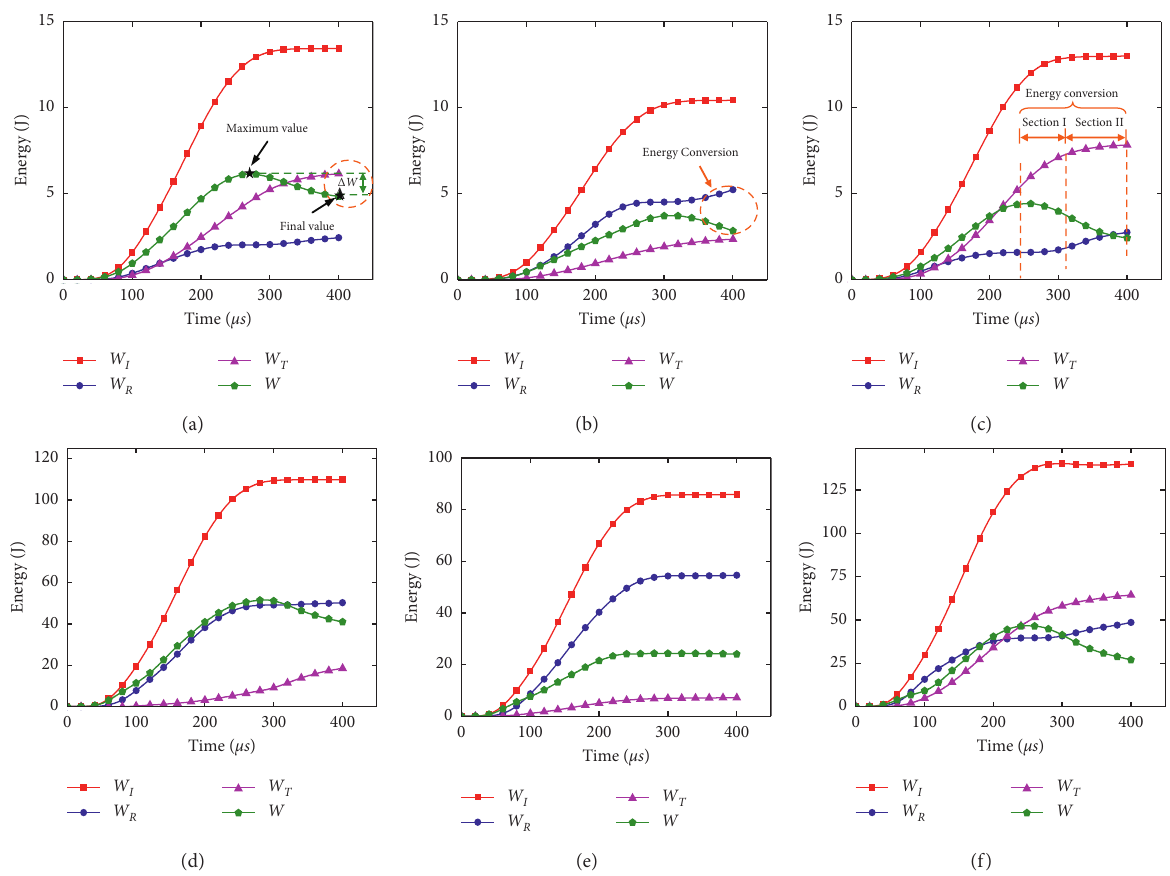
Figure 9: Typical energy–time curves. (a) and (d) for specimen with a joint angle of 15 ° under strain rate of 30s − 1 and 105s − 1 , respectively; (b) and (e) for specimen with a joint angle of 45 ° under strain rate of 30s − 1 and 105s − 1 , respectively; and (c) and (f) for specimen with a joint angle of 75 ° under strain rate of 30s − 1 and 105s − 1 ,